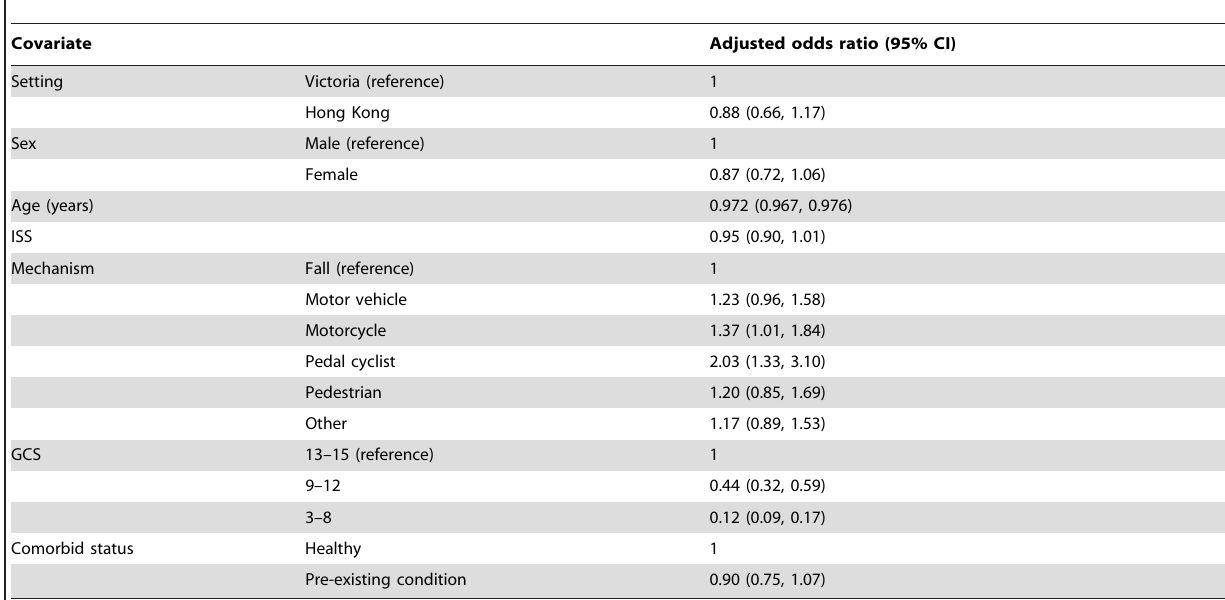
ISS: Injury severity score. GCS: Glasgow Coma Score.